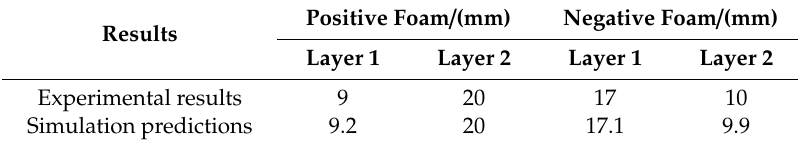
Figure 9. Velocity and crushed distance of the front plate for a positive gradient foam. g = 0.3. Table 6. Comparisons of average cross-section thicknesses of deformed specimens.